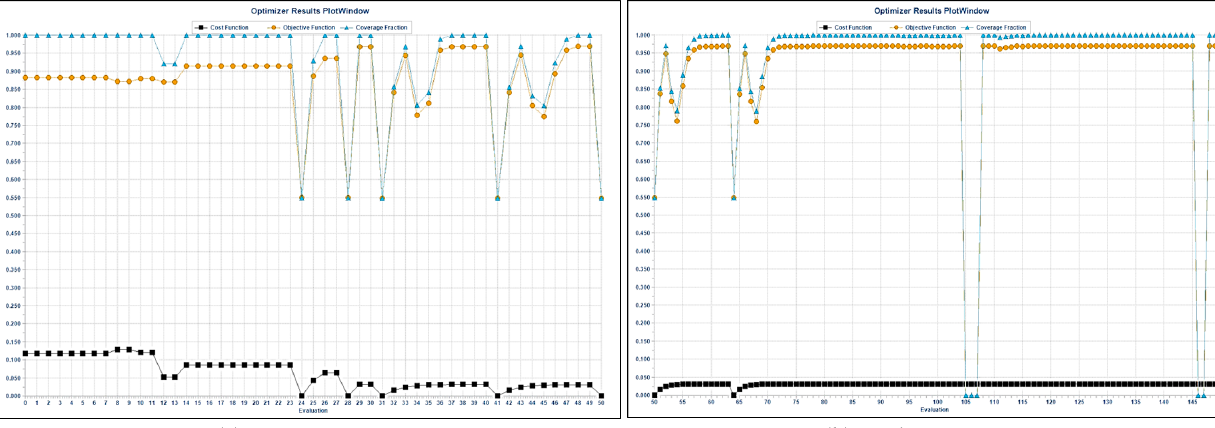
Figure 18. Cost, coverage, and objective optimization process for the first 50 and later iterations.